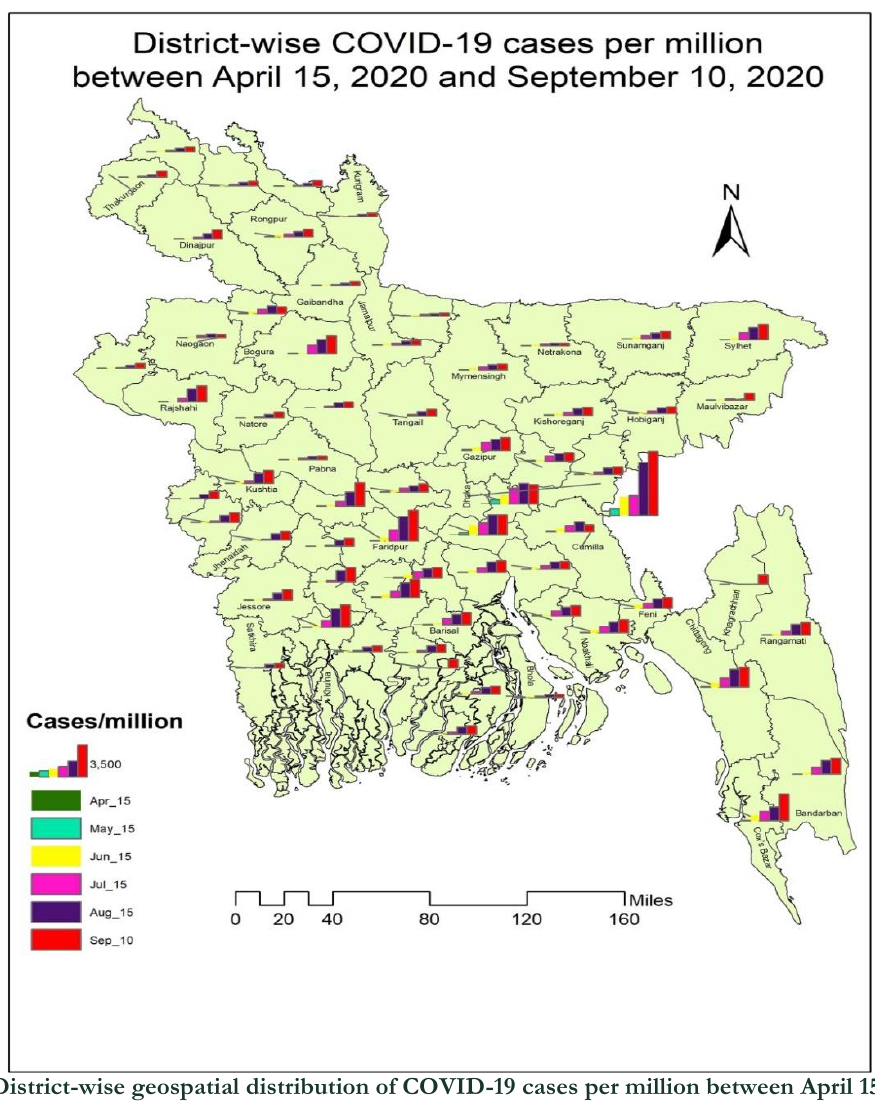
Fig. 1. District-wise geospatial distribution of COVID-19 cases per million between April 15, 2020